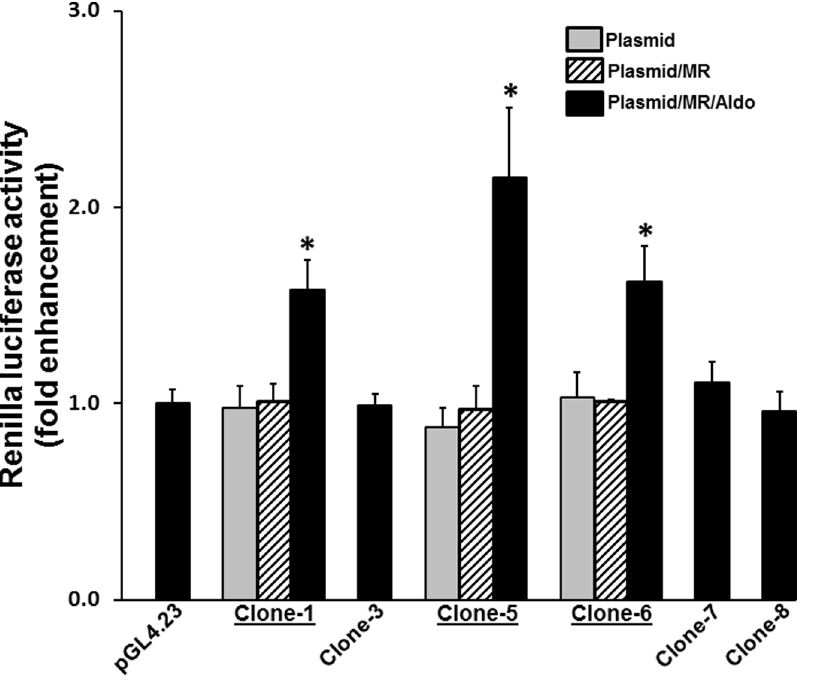
Figure 3. Effect of aldosterone and cortisol concentrations on luciferase activity in mineralocorticoid receptor (MR) and Kcnn4 genomic clones (clone-1, -5 and -6) transfected HEK293T cells. HEK293T cells were transfected with either MR and a vector (pGL4.23) or MR and the respective Kcnn4 genomic clone (clone-1, clone-5 or clone-6). Increasing concentrations (0–100 nM) of either aldosterone or cortisol were determined on luciferase activity. Clone numbers (1, 5 and 6) are indicated to the right. The pGL4.23 transfected cells were unresponsive to both hormones up to 100 nM (data not shown). Murine Mammary Tumor Virus (MMTV) transfected cells exhibited greater than a 30-fold increase in luciferase activity for both hormones with an EC 50 of approximately 1 nM (data not shown). Fitted curves shown were obtained using Graphpad